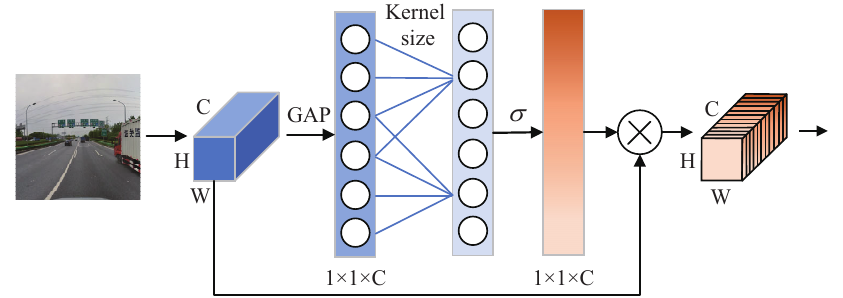
Figure 4. Architecture of the Efficient Channel Attention